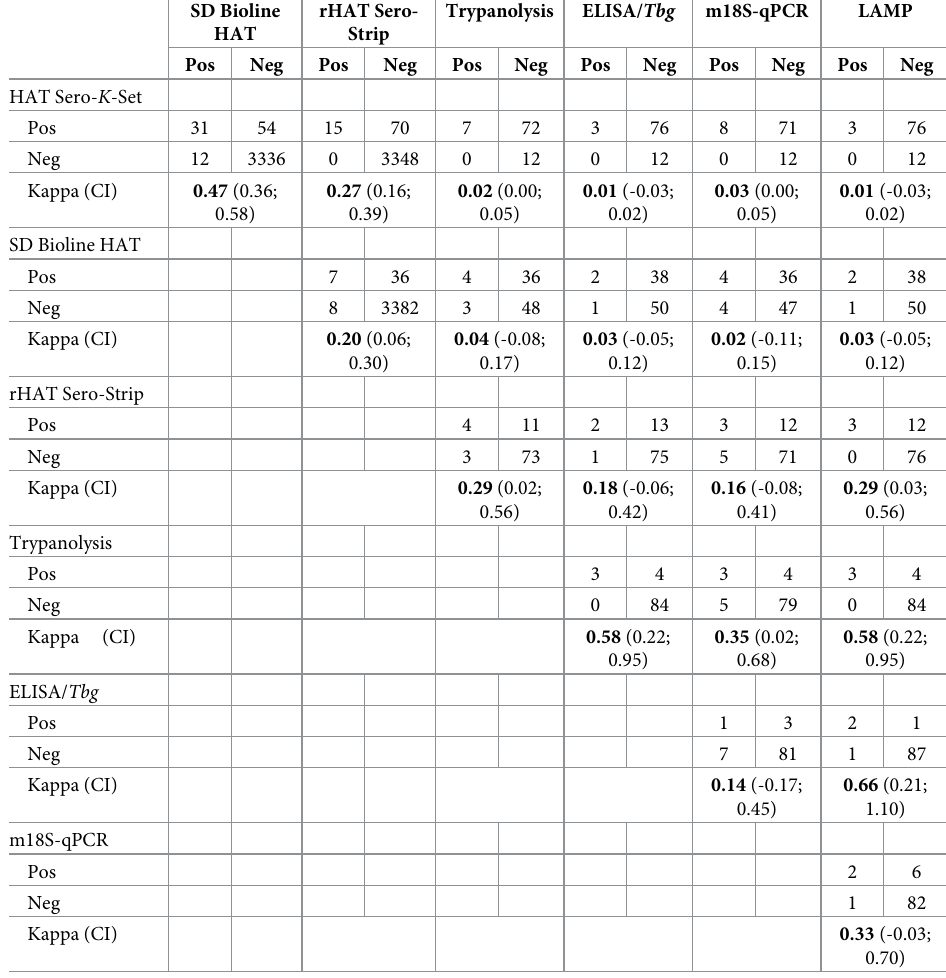
Table 5. Agreement between HAT Sero- K -Set, rHAT Sero-Strip, SD Bioline HAT, trypanolysis, ELISA/ Tbg and LAMP.